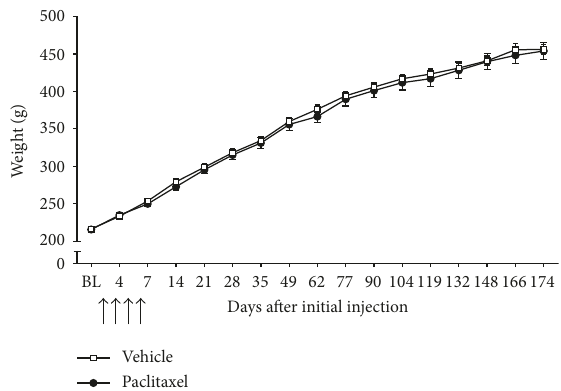
Figure 1: Time course of weight gain in rats following paclitaxel or vehicle administration. Graph shows mean from before paclitaxel/vehicle administration (BL) up to day 174. Arrows indicate four injections of 2mg/kg paclitaxel or equivalent volume of vehicle on days 0, 2, 4, and 6 ( n